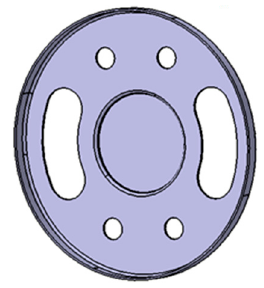
Figure 7. Optimization design of the nozzle.